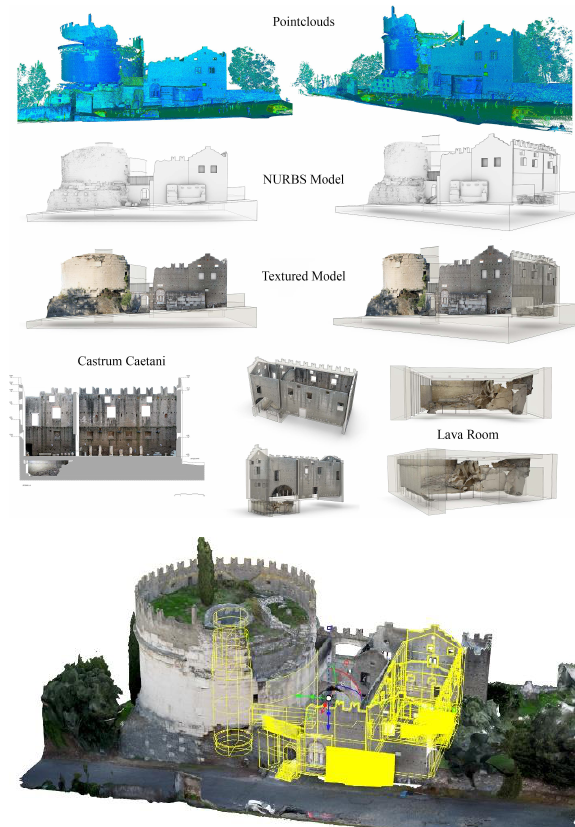
Figure 9. The Scan-to-BIM process applied to the research case